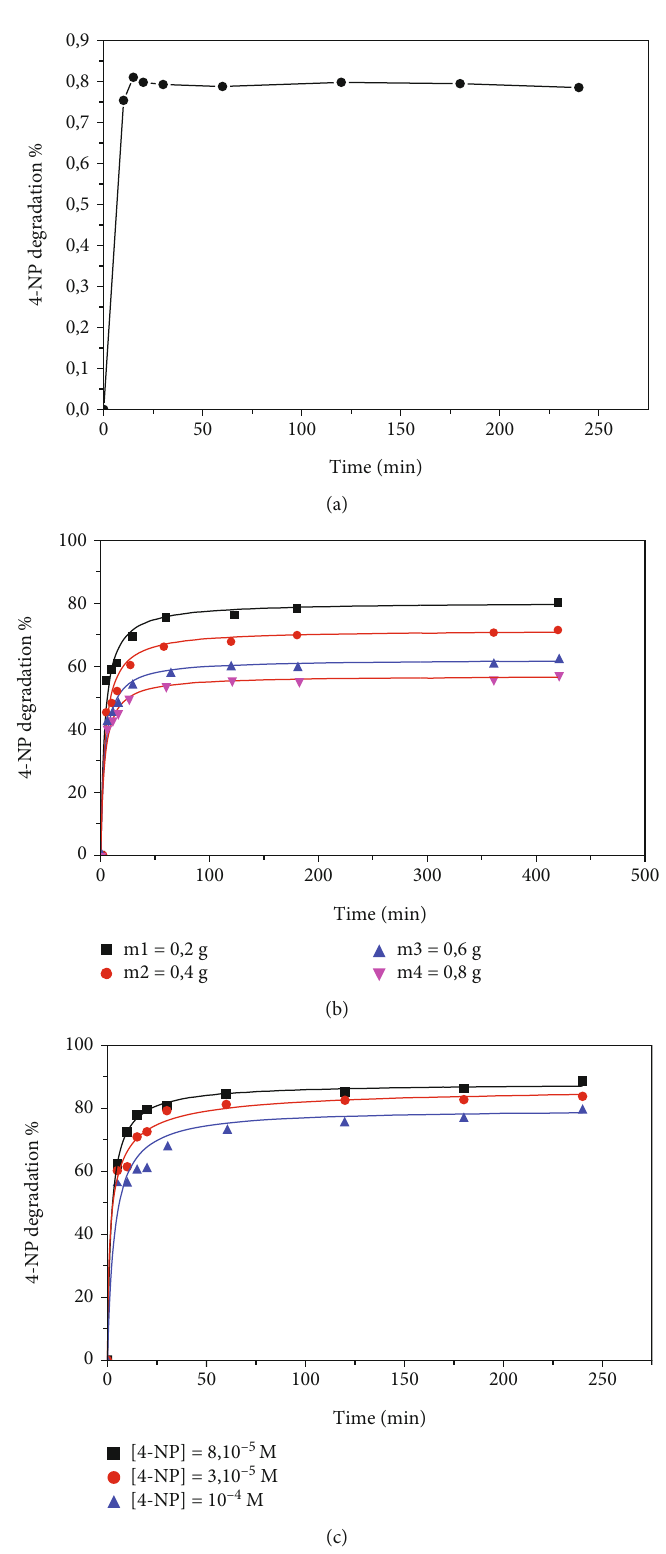
Figure 6: E ff ect of contact time, catalyst mass, and 4-nitrophenol concentration on the degradation yield via catalytic oxidation. Experimental conditions: (a) 0.2g of catalyst, 11 mg/L of 4-nitrophenol concentration, pH 7, and 27 ° C, (b) 11mg/L of 4-nitrophenol concentration, pH 7, and 27 ° C, (c) 0.2 g of catalyst, pH 7, and 27 °